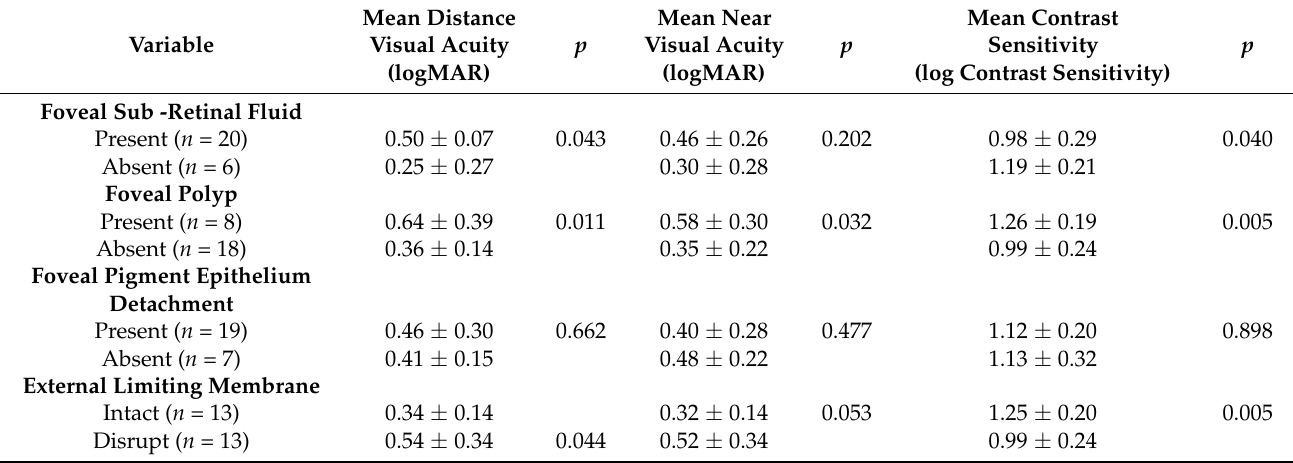
Table 1. Association of qualitative optical coherence tomography (OCT) parameters with visual functions six months after